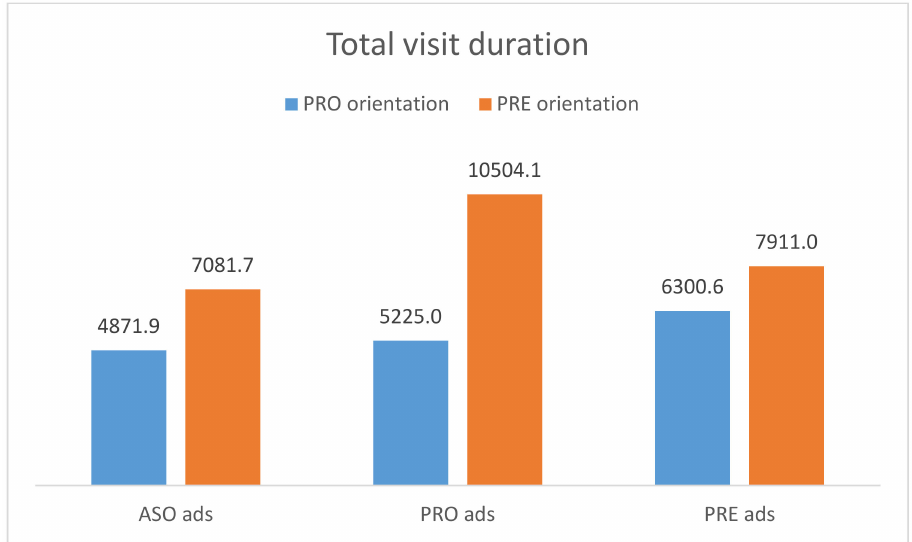
Figure 11. Mean graph for TVD and ad type vs. regulatory orientation (in ms).